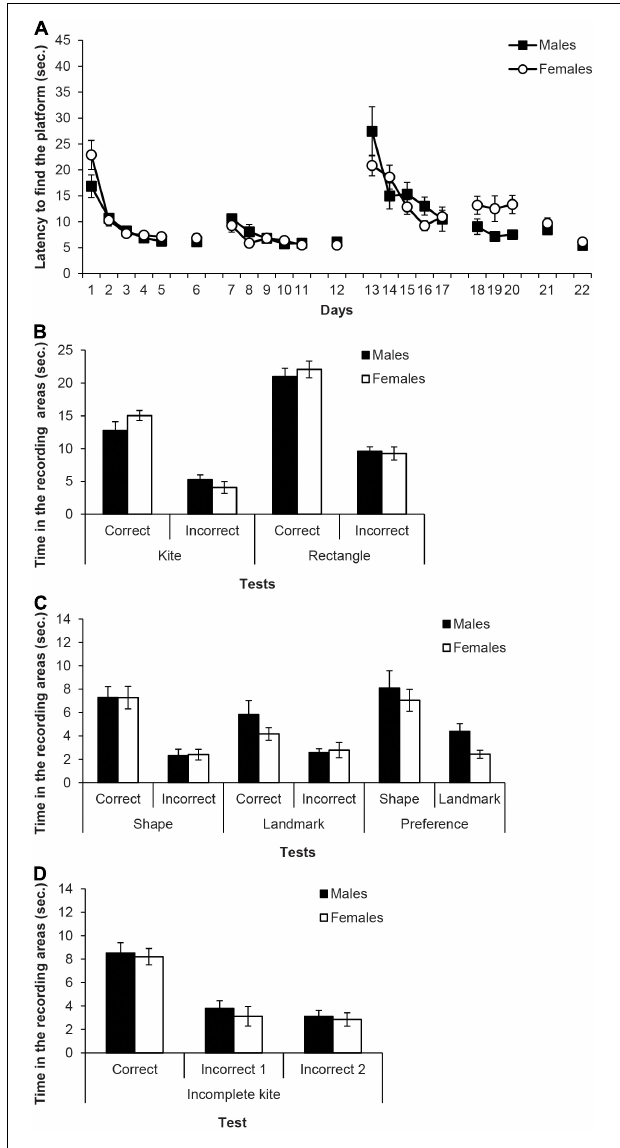
FIGURE 4 | Experiment 2A. (A) Mean escape latencies by the subjects in Experiment 2 during the three training phases and the escape trials of the test days. Error bars denote standard error of the mean. (B) Mean time spent by the subjects in Experiment 2A in the two recording areas (correct and incorrect) during the Kite test trial and Rectangle test trial. (C) Mean time spent by the subjects in Experiment 2A in the two recording areas during the main test trials: Shape test and Landmark test (recording areas: correct and incorrect, C and I, respectively), and Preference test (recording areas: shape and landmark, S and L, respectively). Error bars denote standard error of means. (D) Mean time spent by the subjects in Experiment 2A in the three recording areas -correct, incorrect 1, and incorrect 2 (C, I1, and I2, respectively) during the final test trial with the Incomplete Kite. Error